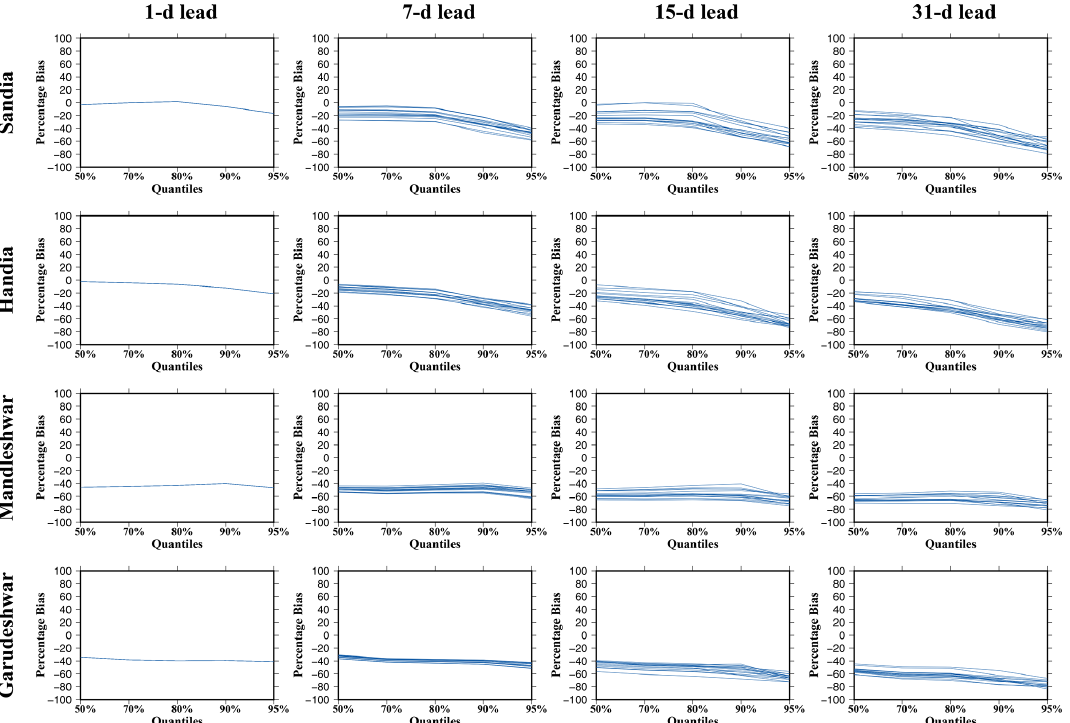
Figure 10. Bias in ensemble streamflow forecast estimated using ERFS for 2003–2018 for streamflow percentiles exceeding 50th, 70th, 80th, 90th, and 95th thresholds. Bias in ensemble streamflow forecast was evaluated at 1, 7, 15, and 31d